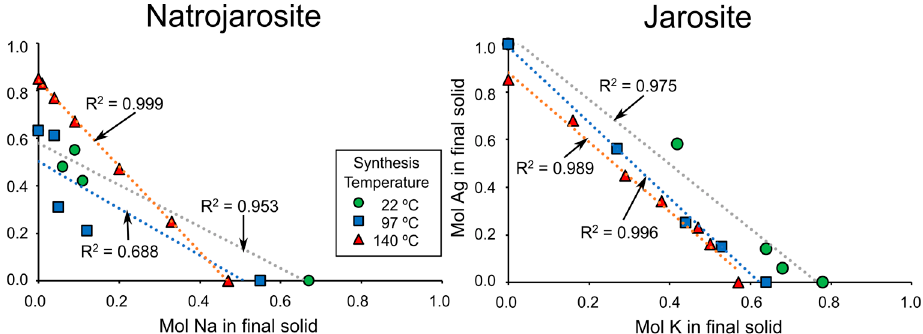
Figure 5. Moles Ag in the final synthesised natrojarosite and jarosite solids compared to moles Na and K in the final solids, respectively.